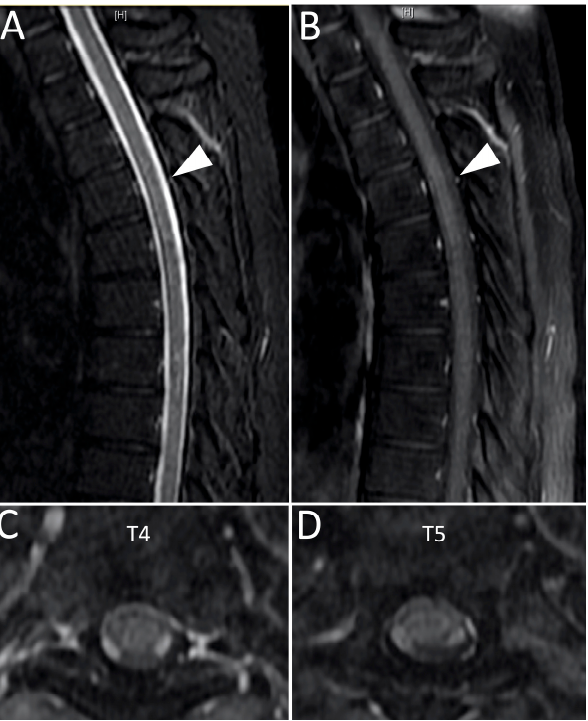
Figure 3. The follow ‐ up MRI 16 weeks after vaccination of the thoracic spine on the T2 ‐ weighted short tau inversion recovery scan ( A ) and post ‐ contrast T1 ‐ weighter fast spin echo scan ( B ) revealed the recovery of the previous lesion over T1 ‐ T6 (indicated by arrowheads). The axial view of the post ‐ contrast T1 ‐ weighter fast spin echo scan over T4 ( C ) and T5 ( D ) also had similar findings.